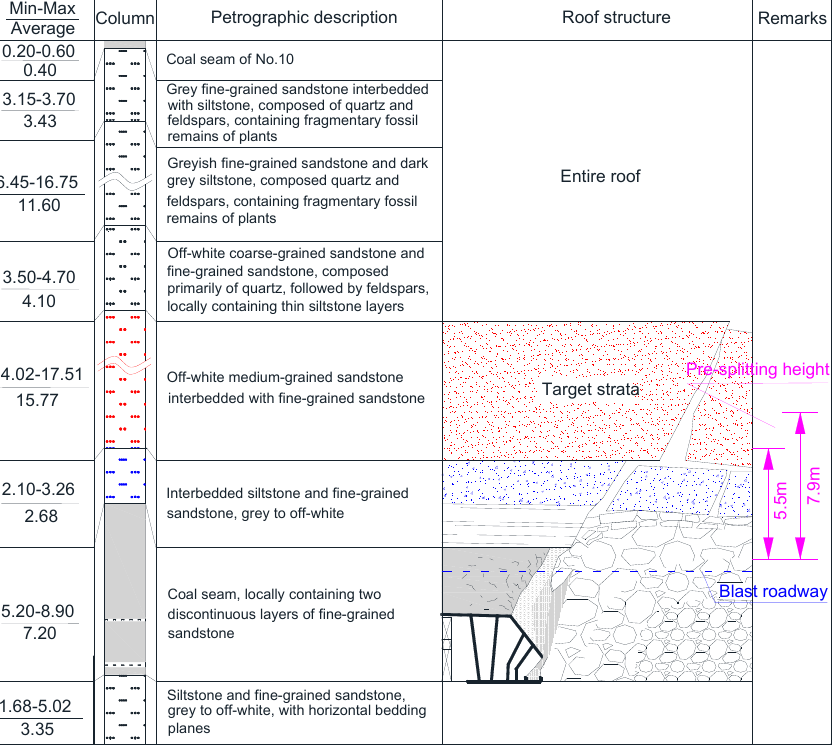
Figure 9. Stratigraphic column of the coal face.